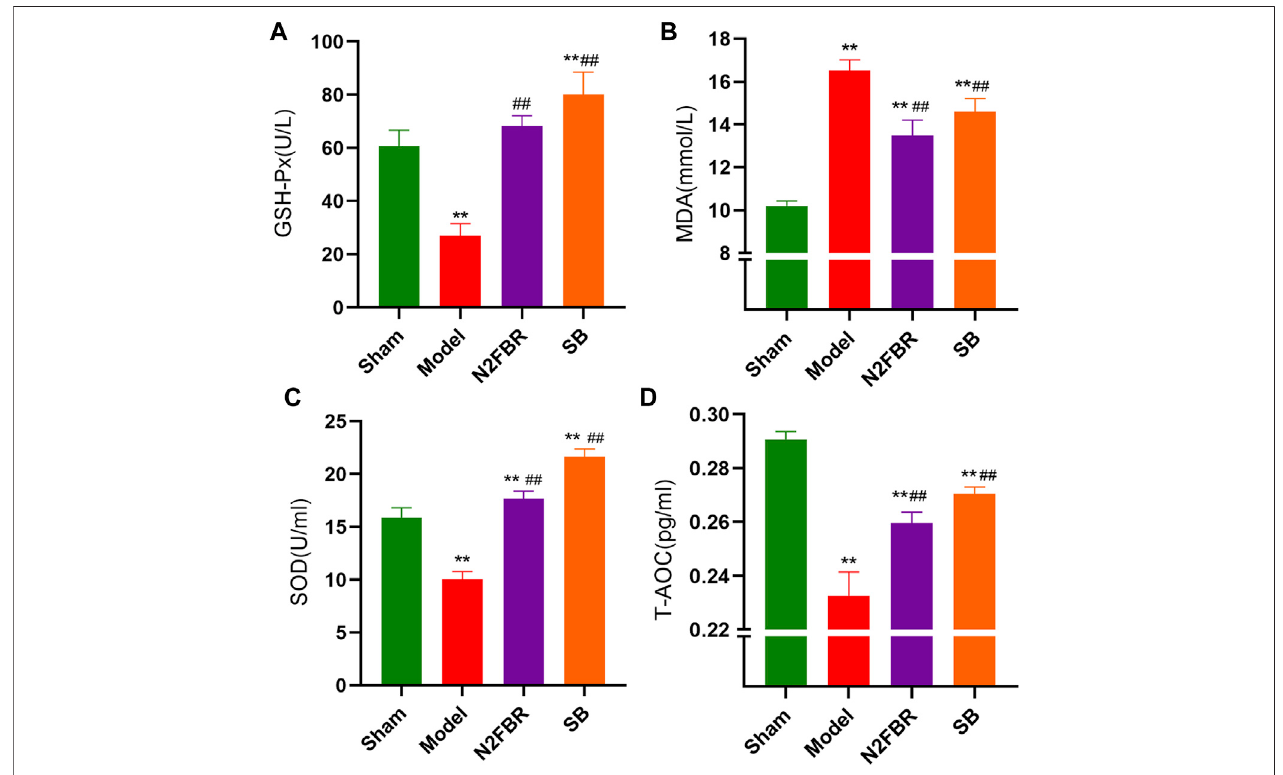
FIGURE 4 | Effects of N2FBR on oxidative stress. Total serum levels of (A) GSH-Px, (B) MDA, (C) SOD, (D) T-AOC as measured through ELISA. Data are expressed as Mean ± SD: ** p < 0.01, compared with sham group, ## p < 0.01, compared with model group.